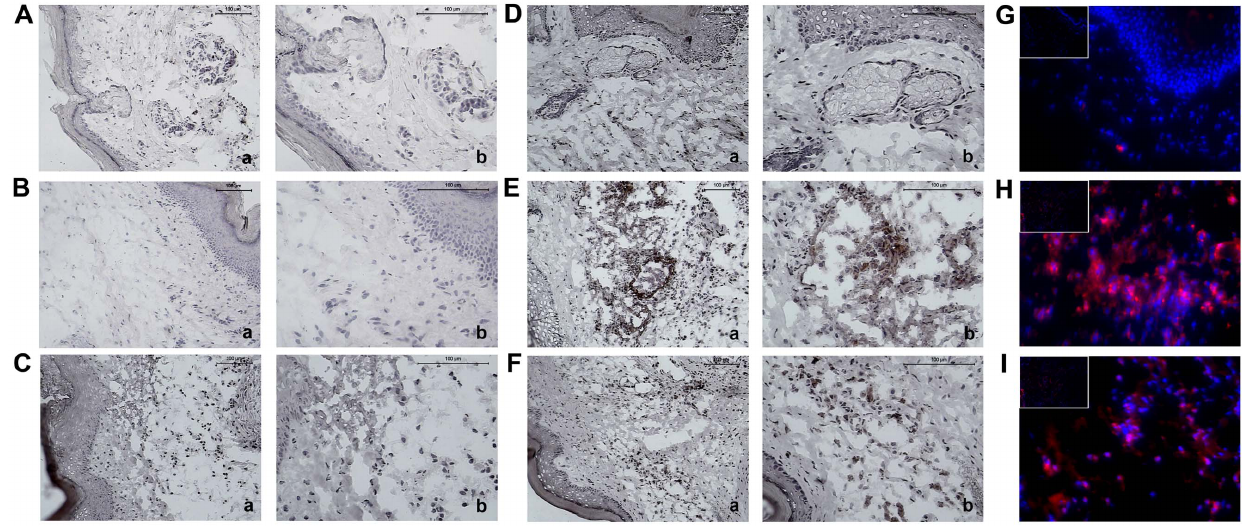
Figure 6. Injection of the P.semirufa bristle extract induces the infiltration of macrophages to the inoculation site. BALB/c mice were repeatedly injected with 50 m L of pyrogen-free saline with or without 10 m g (protein) of the extract in the footpad and, after the 1 st , 3 rd , 5 th and 7 th inoculations, the footpads were removed and frozen for immunohistochemistry and immunofluorescence analysis. Representative photomicrographs of left hind footpads stained with CD11b, injected one ( A and B ) or seven ( D and E ) times with saline and P. semirufa bristle extract, respectively. ( C ) Negative control, injected with extract, marked with matched isotype and ( F ) positive control injected with Carrageenan (200 m g/ paw). Positive immunostaining is indicated by the red-brown colour. Images in panel a are at 200 6 magnification, and images in panel b are at 400 6 magnification. Photomicrograph (400 6 magnification/100 6 magnification in the left upper quadrant) panels G and H show the immunofluorescence analysis of groups inoculated one and seven times, respectively, with P . semirufa bristle extract, while panel I shows the group inoculated with Carrageenan. The DAPI-labelled nuclei appear blue, while the TRITC-labelled target molecules appear red/magenta.